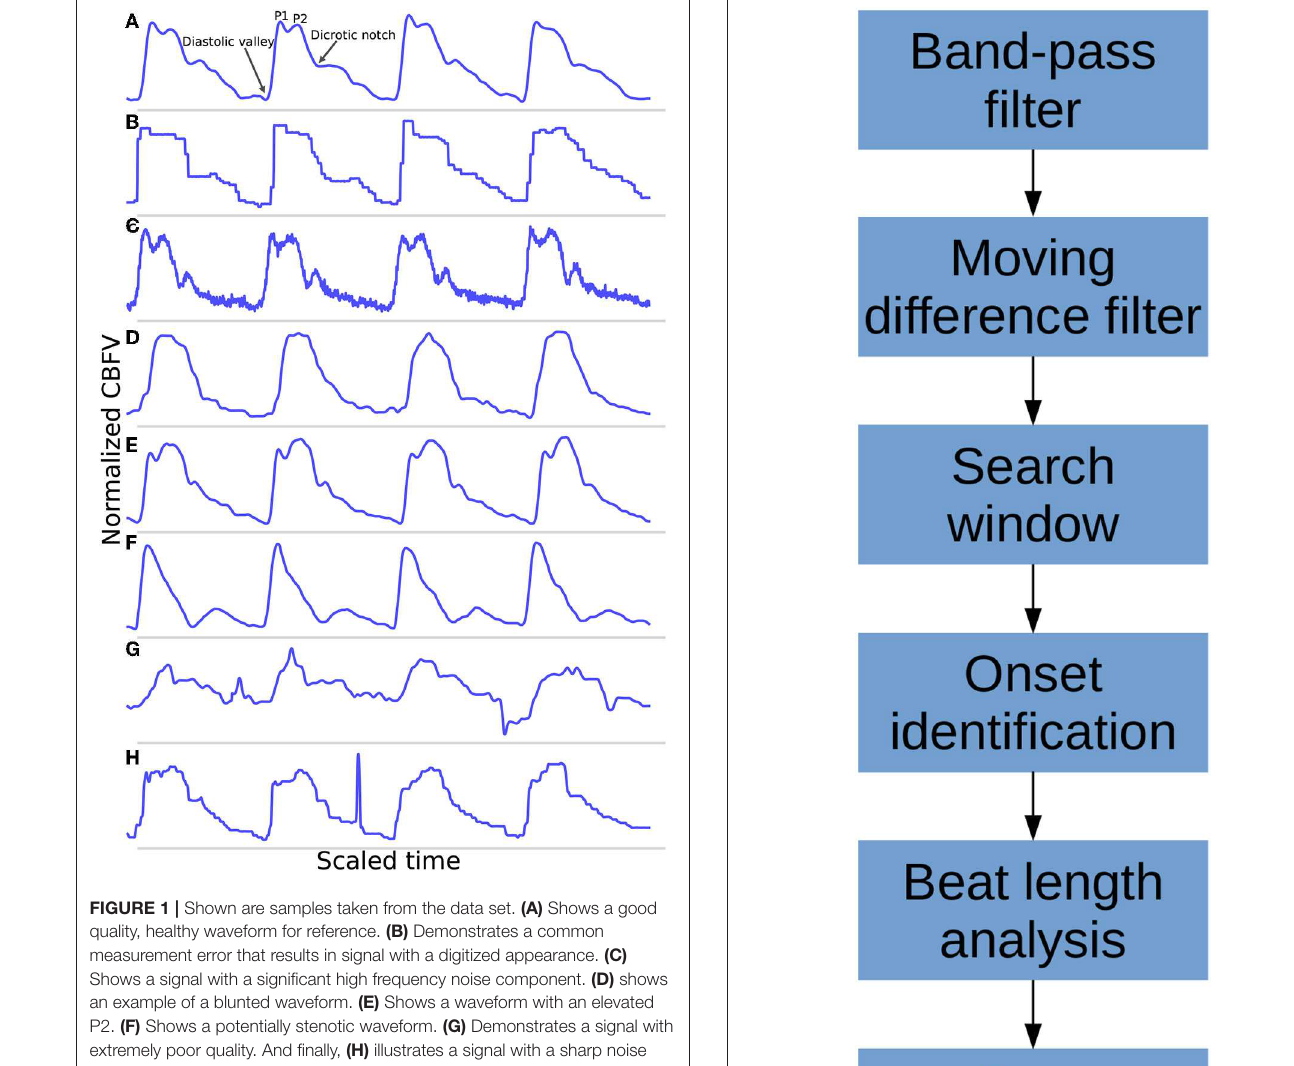
which the second peak (P2) is consistently higher than the first peak (P1). Figure 1F depicts a signal where the dicrotic notch and diastolic valley of each beat are nearly equal, resulting in two clearly distinct peaks of different amplitudes, a characteristic that may be associated with stenotic waveforms defined in Demchuk et al. (22). Figure 1G is meant to be illustrative of the types of extremely poor quality signals encountered in the data, and Figure 1H exhibits a signal with a sharp noise spike, another common feature that might “trick” an algorithm into incorrectly identifying the start of a new